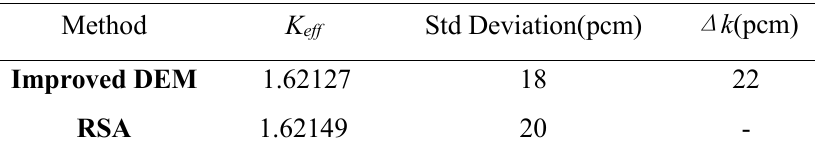
Table Ⅱ . Comparison of explicit modeling